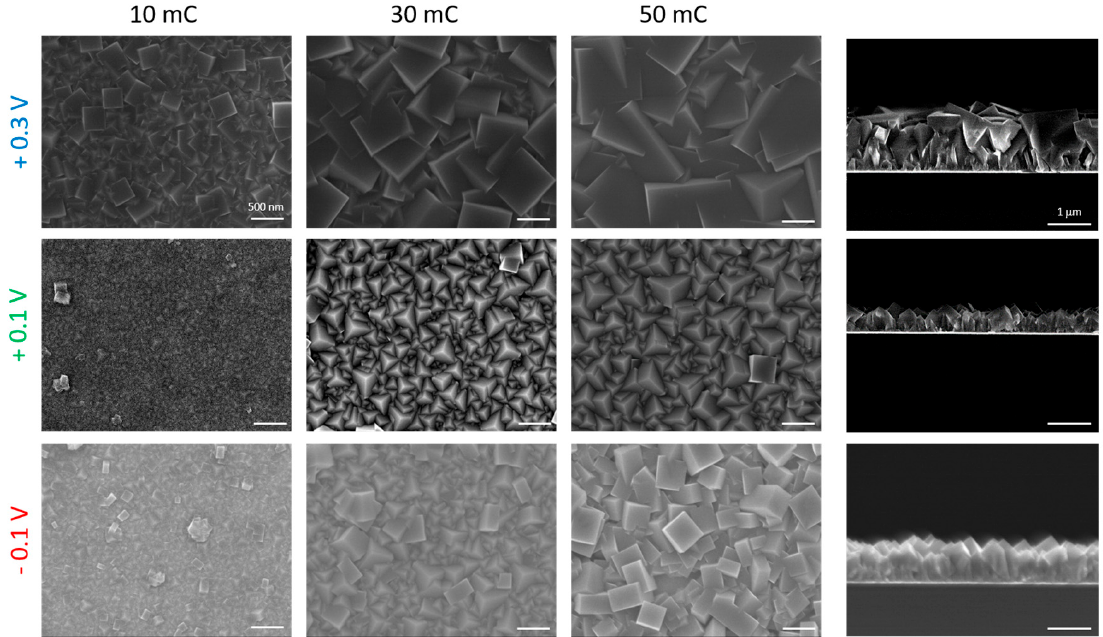
Figure 3. Columns 1, 2 and 3 show SEM–FEG top-view images of samples with an electrodeposited charge of 10, 30 and 50 mC, respectively. The lines 1, 2 and 3 are for deposition potentials of 0.30, 0.10 and − 0.10 V, respectively. Column 4 is cross-section SEM–FEG images of samples grown with 50 mC at the three different potentials